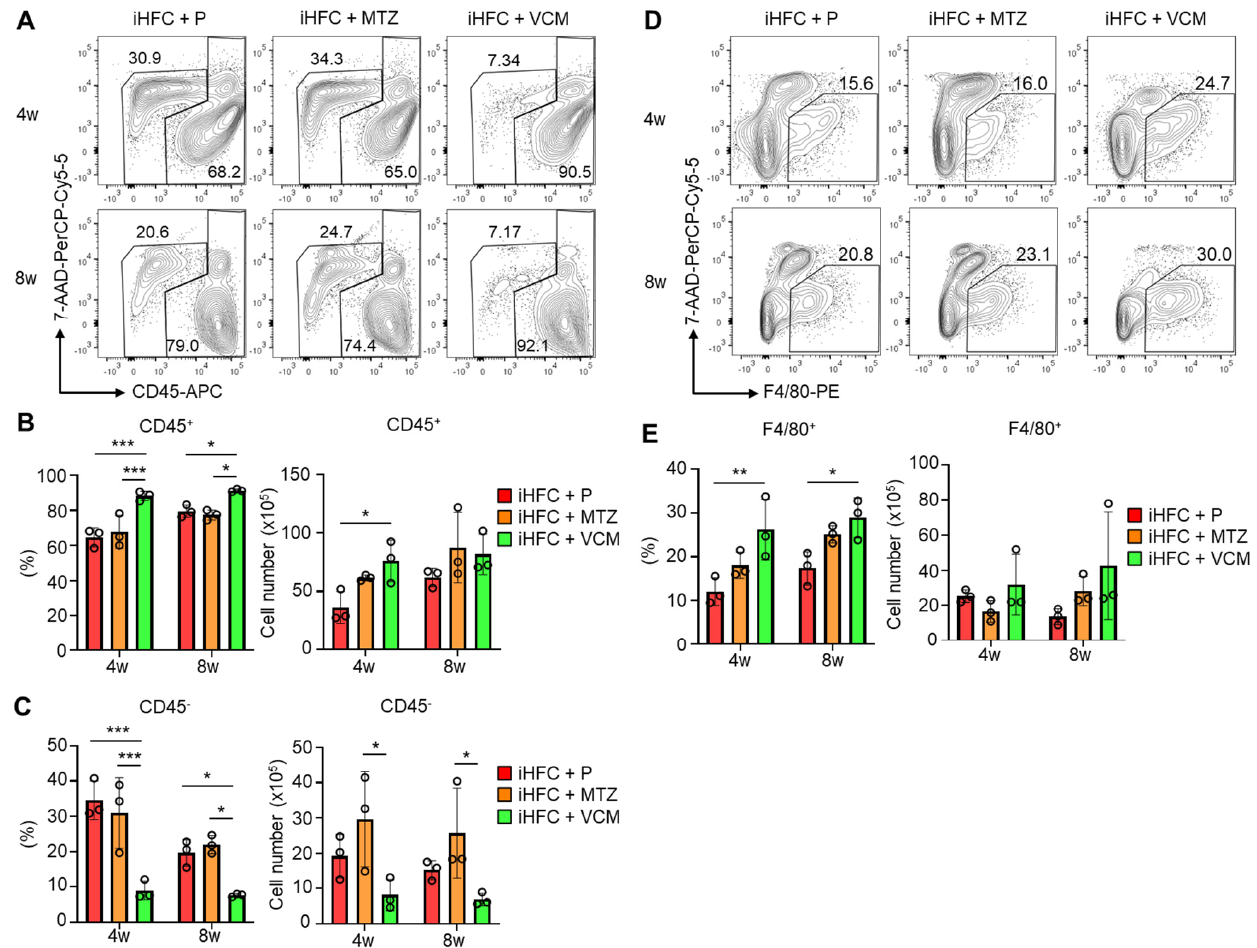
Figure 4. VCM treatment augments iHFC diet-induced accumulation of CD45 + leukocytes and F4/80 + macrophages in the liver of TSNO mice. ( A ) Representative flow cytometry data of CD45 expression on non-parenchymal cells including KCs and excluding 7-AAD + dead cells of the liver from placebo- or antibiotic- treated TSNO mice on the iHFC diet. ( B ) Percentage (Left) and cell number (Right) of CD45 + live non-parenchymal cells were determined by flow cytometry analysis conducted in Figure 4A (n = 3 per group). ( C ) Percentage (Left) and cell number (Right) of CD45 − live non-parenchymal cells were determined by flow cytometry analysis conducted in Figure 4A (n = 3 per group). ( D ) Single non-parenchymal cells were analyzed with a plot of F4/80 and 7-AAD, and then gated on live F4/80 + cells excluding dead cells and highly auto-fluorescent F4/80-positive KCs. ( E ) Percentage (Left) and cell number (Right) of F4/80 + -recruited macrophages were determined by flow cytometry analysis conducted in Figure 4D (n = 3 per group). Data are shown as means ± SD. * p < 0.05, ** p < 0.01, *** p < 0.001.